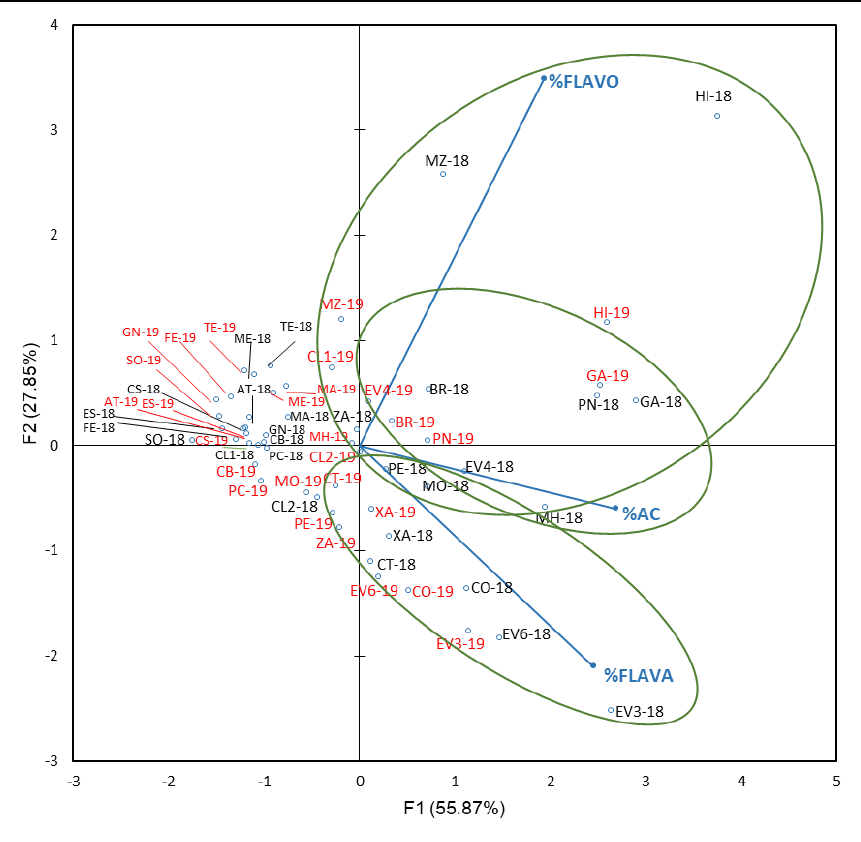
Figure 5. Principal component analysis on non-anthocyanin phenolic compounds profile (percentage) of grapes from the EVEGA germplasm bank in 2018 and 2019 vintages. % FLAVO, % FLAVA, and % AC are percentages of flavonols, flavanols and phenolic acids, respectively. Data for the black and red varieties reflect the data for 2018 and 2019 harvests respectively. See Table 1 for varieties abbreviations.